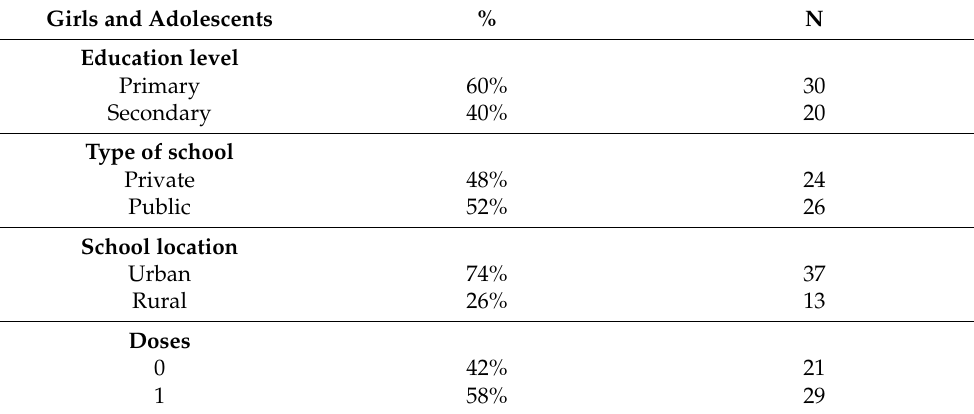
Table 2. Sociodemographic characteristics of girls and adolescents in focus groups (N = 50).